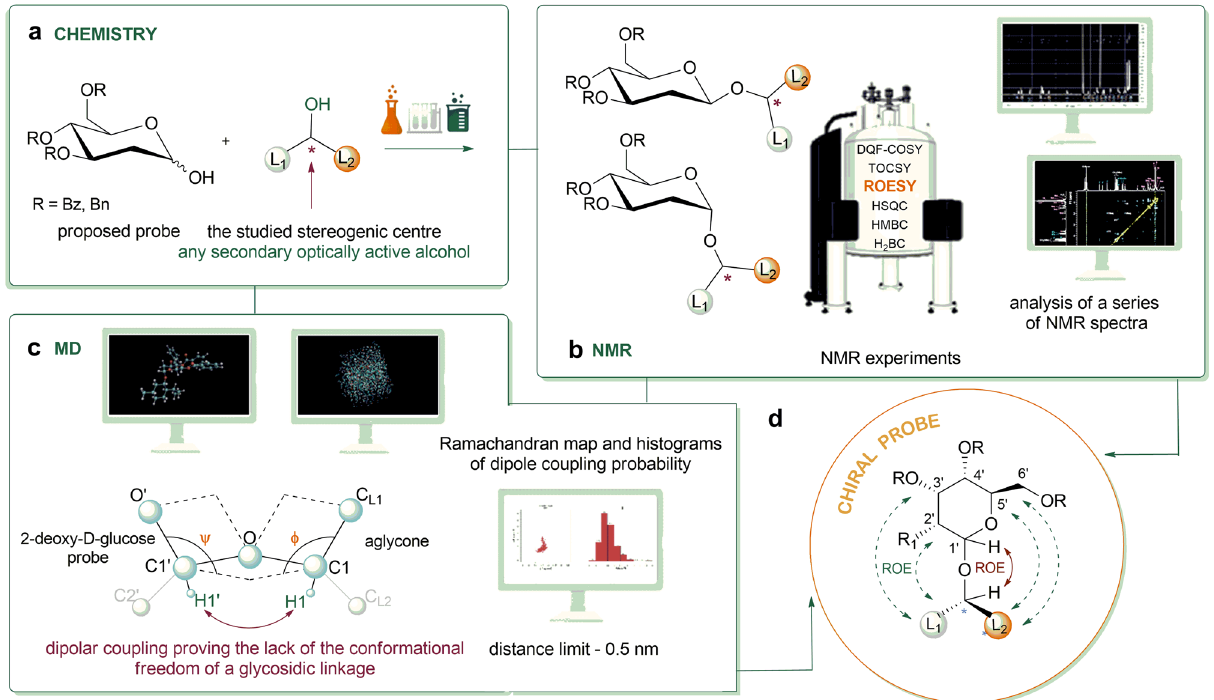
Figure 1. The illustration introduces the general concept of the method: ( a ) synthesis of the proposed probe and its reaction with a selected chiral secondary alcohol; ( b ) NMR experiments and analysis of one- and two- dimensional spectra; ( c ) computer simulation of the probe-aglycon system with selected data related to dipole connections and definition of double-walled angles Φ and Ψ; ( d ) comparison of NMR results with